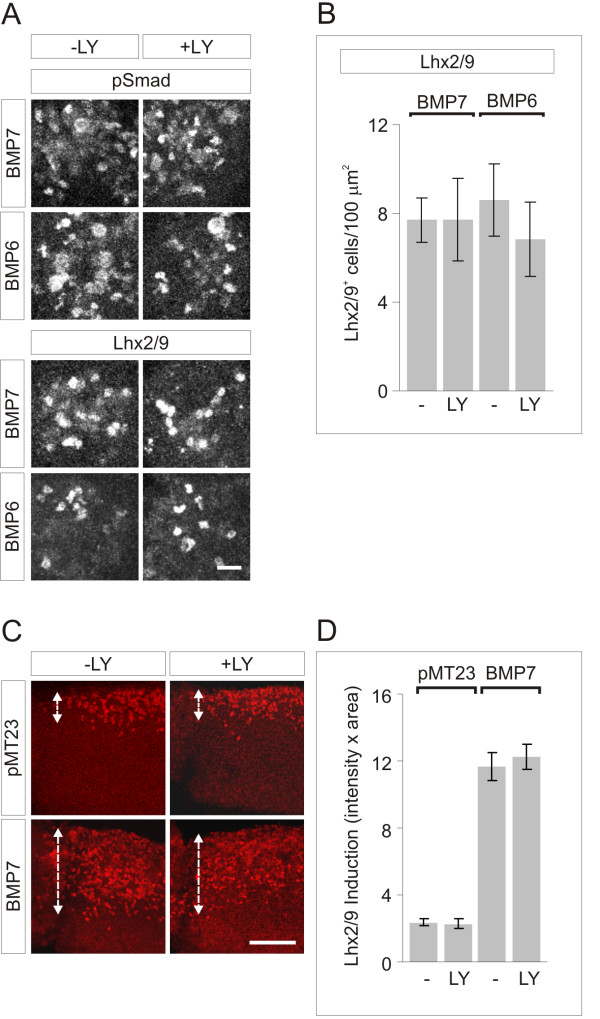
Inhibition of PI3K activity has no effect on BMP7-induced Lhx2/9 expression. (A) [i] explants treated with BMP7 or BMP6 (20 ng/ml) with or without 2.5 μM LY and labeled with α-pSmad1/5/8 (upper panels) and α-Lhx2/9 (lower panels). Scale = 20 μm. (B) Quantification of Lhx2/9+ cells/100 μm 2 in [i] explants: BMP7 - LY = 7.7 ± 1.0 cells; BMP7 + LY = 7.7 ± 1.9 cells; BMP6 - LY = 8.6 ± 1.6 cells; BMP6 + LY = 6.8 ± 1.7 cells; (n = 2) (mean ± SEM for each condition). LY had no effect on Lhx2/9 expression induced by either BMP7 or BMP6 (BMP7 - LY versus BMP7 + LY, P = 0.9997; BMP6 - LY versus BMP6 + LY, P = 0.4942 (Student's t-test)). (C) Lhx2/9-labeled (red) [d] explants co-cultured with control- or BMP-7-expressing COS-1 cells with or without 2.5 μM LY. Double-headed arrows mark the width of the control and induced Lhx2/9-expression regions. Scale = 50 μm. (D) Quantification of Lhx2/9 induction in [d] explants, measured as in Figure 3C: pMT23 - LY = 4.48 ± 0.44 (n = 8); pMT23 + LY = 4.85 ± 0.55 (n = 8); BMP7 - LY = 14.02 ± 1.0 (n = 17); BMP7 + LY = 12.42 ± 0.78 (n = 18). Mean × 105 ± SEM for each condition. Student's t-tests: there was no difference in the expression levels of Lhx2/9 with or without LY in either control [d] explant co-cultures (pMT23 - LY versus pMT23 + LY, P = 0.8002) or BMP7-induced [d] explants (BMP7 - LY versus BMP7 + LY, P = 0.5978).